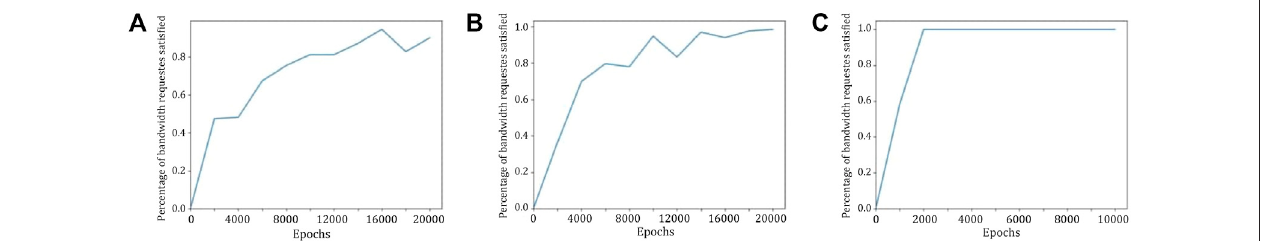
FIGURE 5 | Percentage of satis fi ed bandwidth requests with 1 UAV (A) , 2 UAVs (B) , and (3) UAVs in case of 10 users.